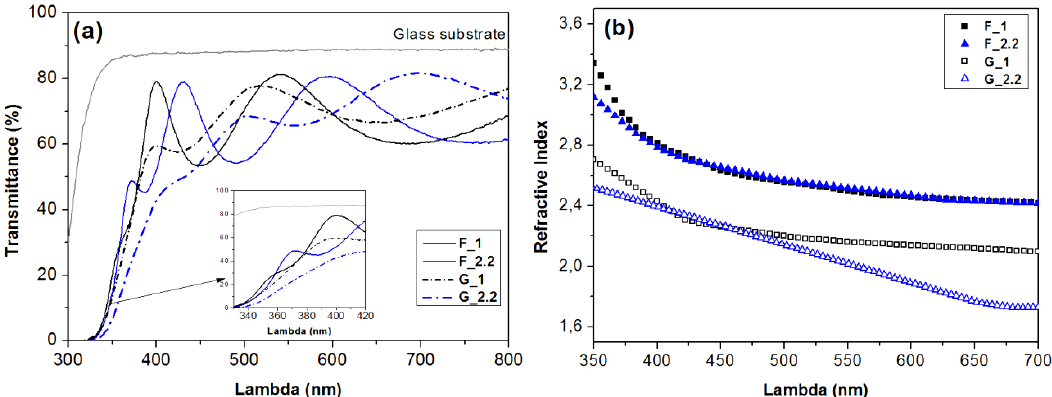
Figure 3. ( a ) UV – vis transmittance spectra of the 0°-substrate-angle-deposited films (solid lines) and 87° glancing-angle-deposited films (dashed lines) and ( b ) the corresponding refractive indices, estimated using the Pointwise Unconstrained Minimization Approach (PUMA) computational method [20].